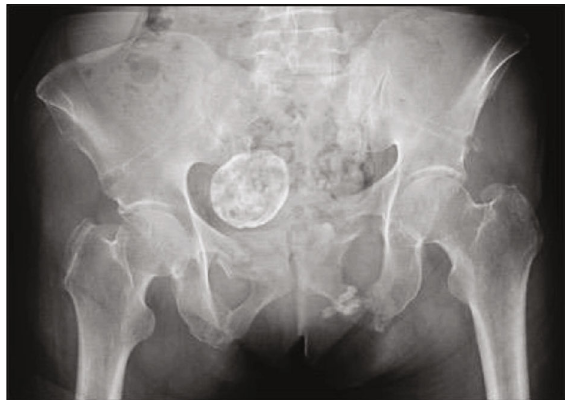
Figure 6: Anteroposterior pelvis radiograph after removal of the external fi xator with healing of pubic rami fractures and presence of the antibiotic